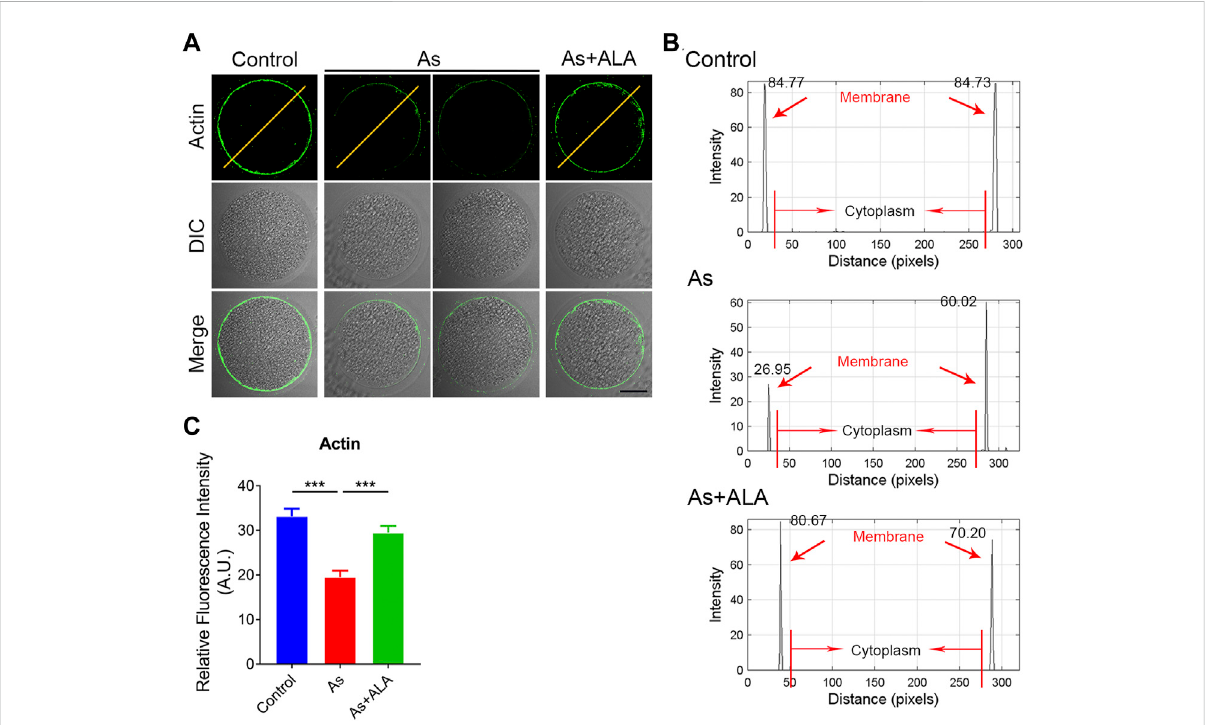
Effect of ALA supplementation on actin dynamics in arsenite-exposed oocytes. (A) Representative images of the localization of micro fi laments in control, arsenite-exposed and ALA-supplemented groups. Scale bar, 30 µm. (B) The graphs showed the fl uorescence intensity pro fi ling of actin fi laments control, arsenite-exposed and ALA-supplemented groups. Pixel intensities were measured along the lines which were drawn across the oocytes. (C) The fl uorescence intensity of actin signals in control, arsenite-exposed and ALA-supplemented groups. Data were presented as mean percentage (mean ± SEM) of three independent experiments. *** p <